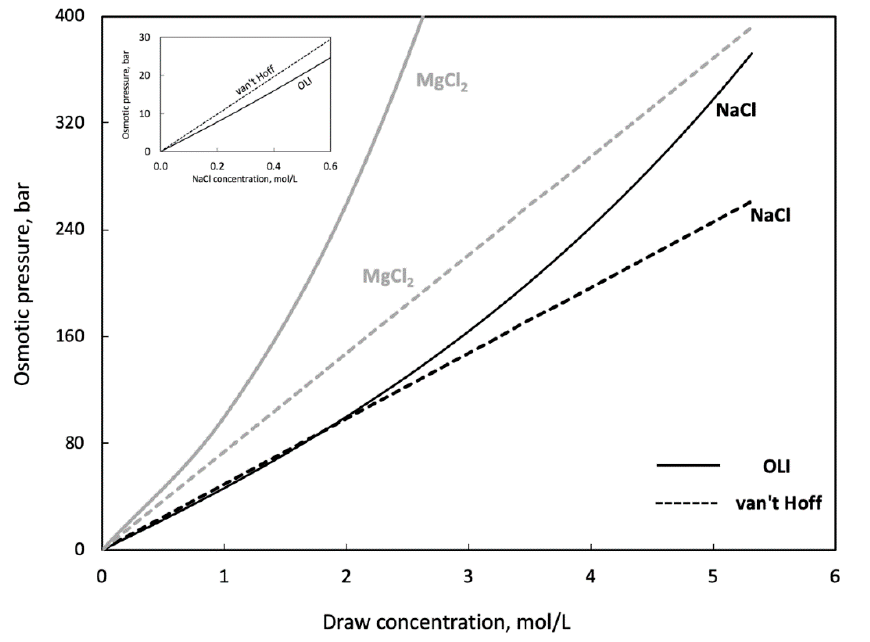
Figure A2. Osmotic pressure, predicted by the van ’t Hoff linear approach and the OLI Streamline Analyzer software, as a function of the solute concentration for NaCl and MgCl 2 . The vertical axis corresponds to the osmotic pressure.